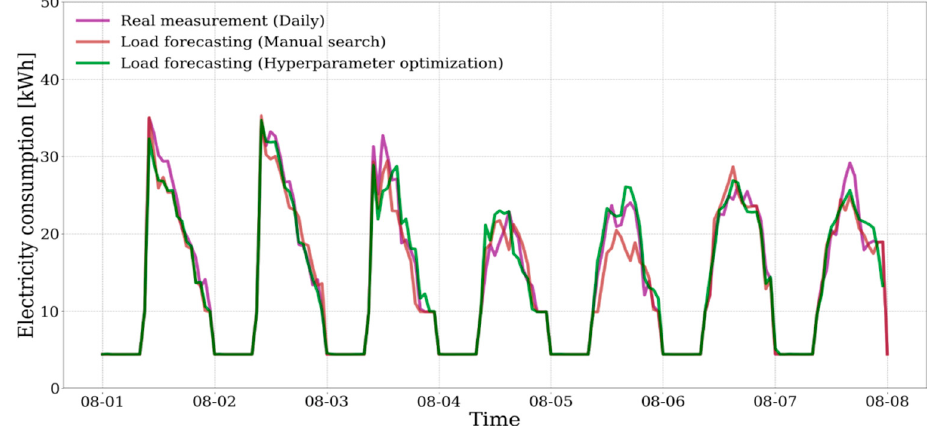
Figure 10. Load forecasting result with weekly model and simulation data.